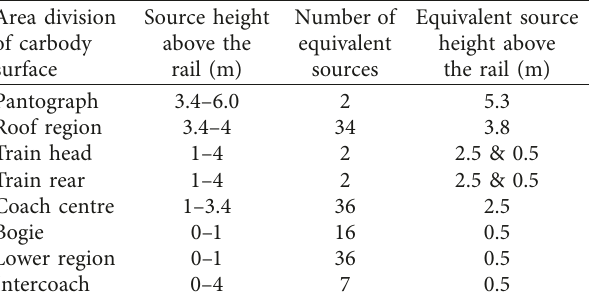
Table 4: The numbers and heights of equivalent noise sources.